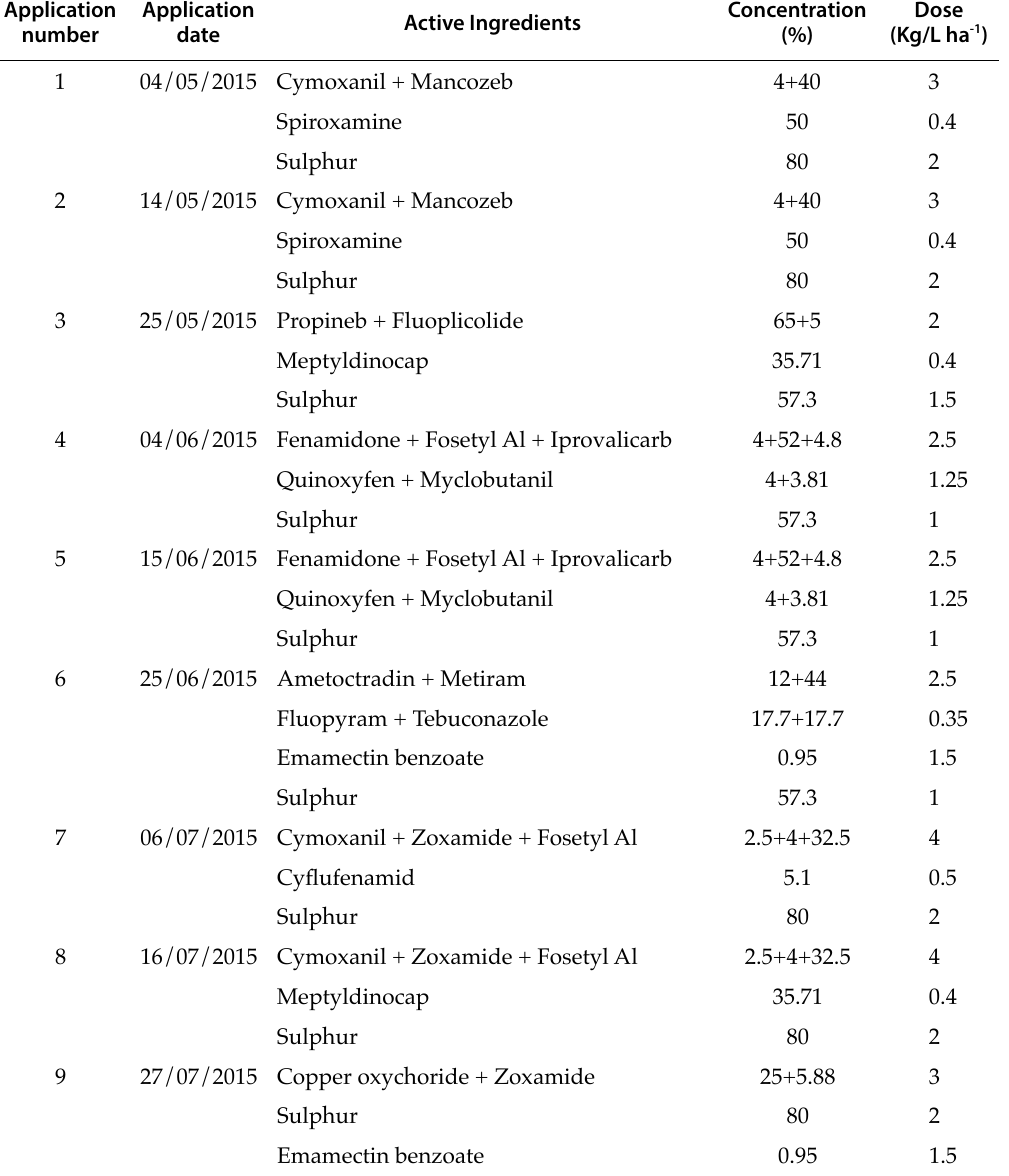
Table 3. Active ingredients distributed in tank mixes with the mixture of CaCl biano d’Abruzzo vineyard in